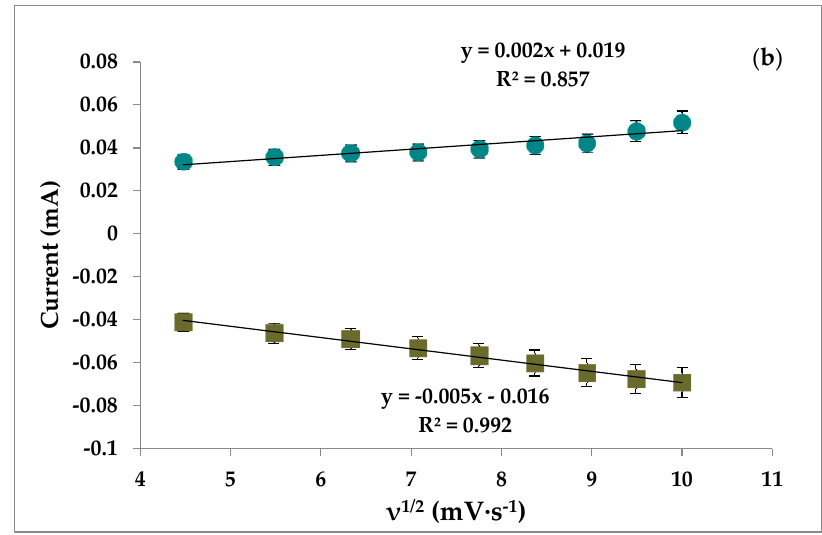
Figure 5. Calibration curve of redox peak and √ scan rate for ( a )bare Au electrode and ( b ) SnNPs@Au-modified electrode to determine electroactive surface areas.